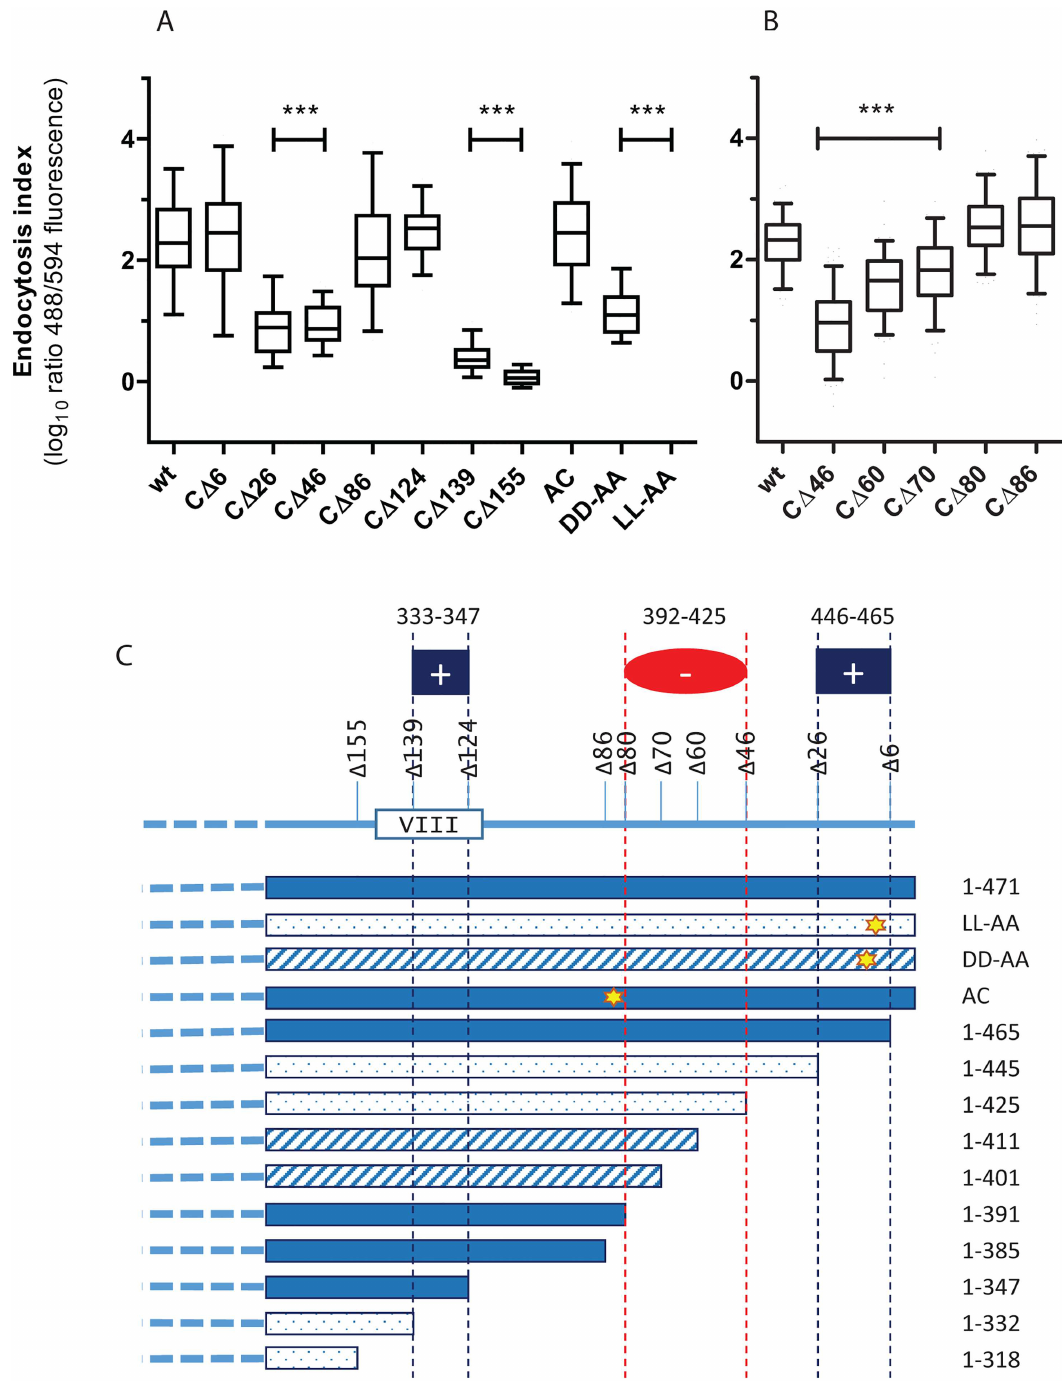
Fig 3. Endocytosis assay of M78 mutants. Hela cells were transfected with plasmidsexpressing HA-tagged M78, either wild type (wt), C-terminally truncated (C Δ 6—C Δ 155) or with mutations of the acidic cluster (AC) or the acidic dileucine motif (DD-AA or LL-AA). One day post-transfection, cells were analysedfor endocytosisvia antibody feeding (rabbit anti- HA, 1hr), then fixed and processed for immunofluorescenceeither before (AF 594 conjugatedanti-rabbit) or after (AF 488 conjugated anti-rabbit) permeabilisation. Panels A and B show results for two independent experiments. Coverslips were mounted and images of random fields captured using the 594 and 488 fluorescence filters. Images were analysedusing ImageJ software to determine the fluorescence intensity of both the 594 and 488 channels for each transfected cell ( > 50 cells analysedfor each group). The endocytosis index (EI) is plotted as the ratio of intensities (488/594),